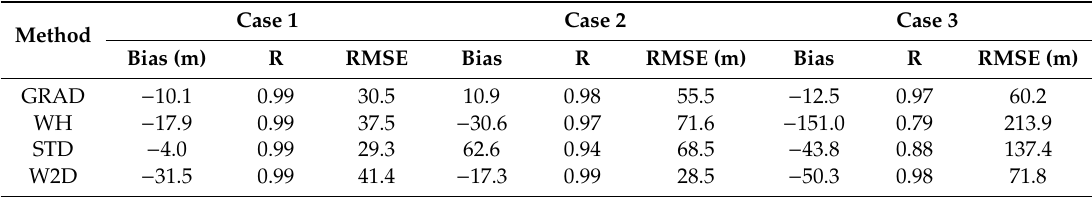
Table 2. Evaluations of di ff erent methods using ideal